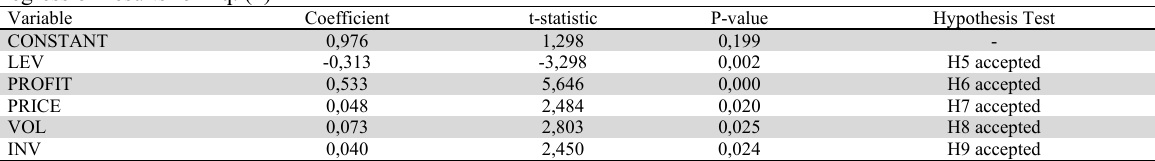
Regression results for Eq.